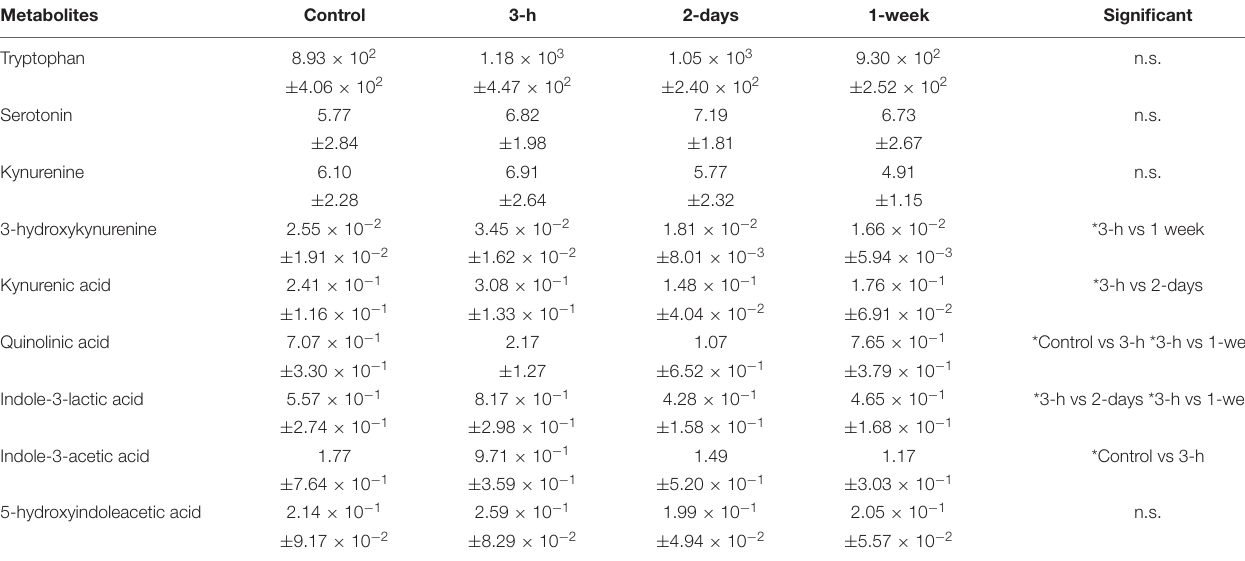
TABLE 7 | Concentrations of tryptophan derivates in blood serum samples using targeted HPLC-MS method.